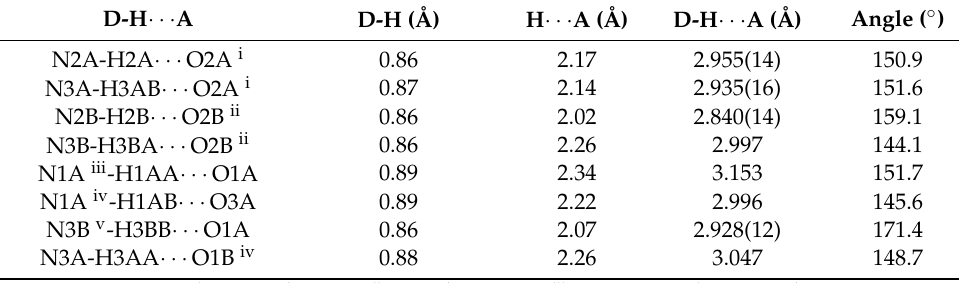
Figure 3. ( a ) Perspective view of all the hydrogen bonds in the structure. The different layers are indicated in orange and light green color, while intra- and intermolecular hydrogen bonds are in light blue and purple dotted lines, respectively. ( b ) Detail of the intramolecular H-bonds, which gives rise ( 6 ) and R 2 ( 8 ) ring motives. to a R 1 2 2 Table 2. Hydrogen bonds for compound [Cu(Citr) 2 ] n